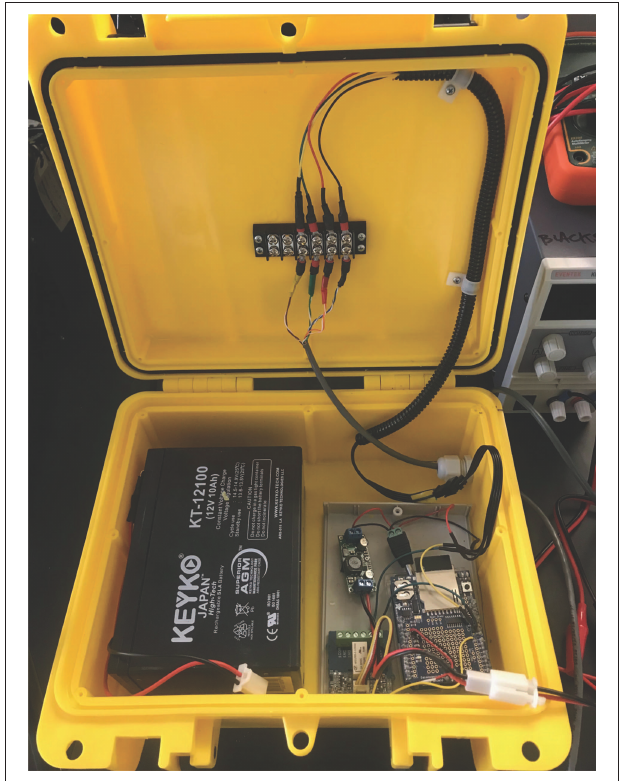
FIGURE 2 | Arrangement of 12V battery power source, voltage regulator, Arduino-based data logger, relay switch, and terminal block connections that lead to a waterproofed K30. Terminal block was used to reduce physical strain and potential disruption to interior wired connections in the event the connecting cable to the waterproofed K30 is disturbed (e.g., external force pulling cable out of the box).